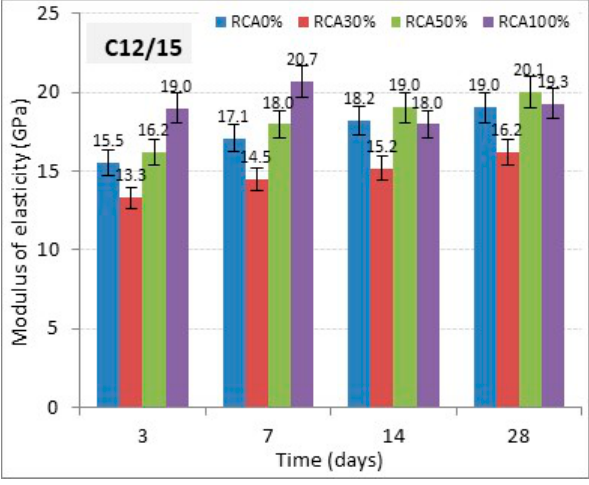
Figure 5. Effect of proportions of RCA on the modulus of elasticity development for C12/15 Figure 5. E ff ect of proportions of RCA on the modulus of elasticity development for C12 / 15 concretes. concretes.